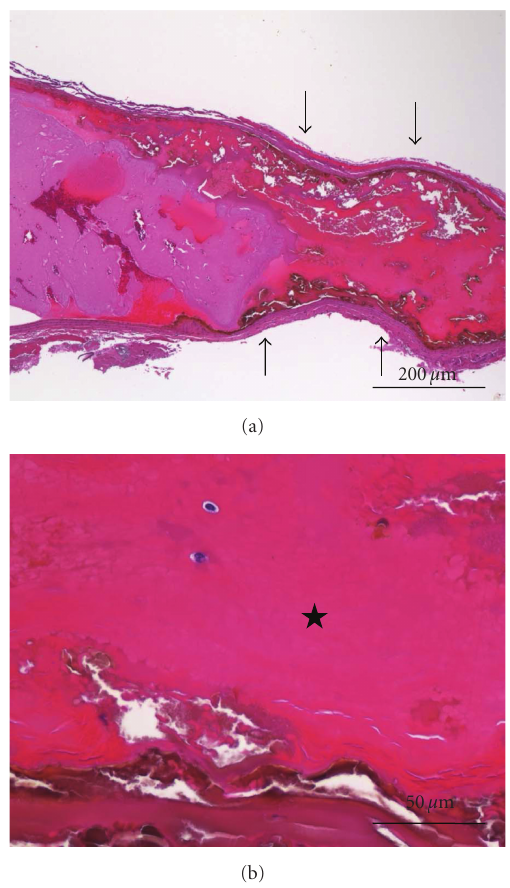
Figure 3: Histological images of carotid artery from rat ferric chloride model. (a) Longitudinal section of rat carotid artery 20 minutes after initiation of 20% ferric chloride injury. Arterial wall and blood show marked degenerative or denaturation changes at site of injury (arrows), wall constriction, and brown color at blood- vessel interface. Hematoxylin eosin stain. (b) Higher magnification of attached thrombus ( ∗ ) shows absence of cellular and fibrillar structures and rather homogeneous appearance. Hematoxylin eosin